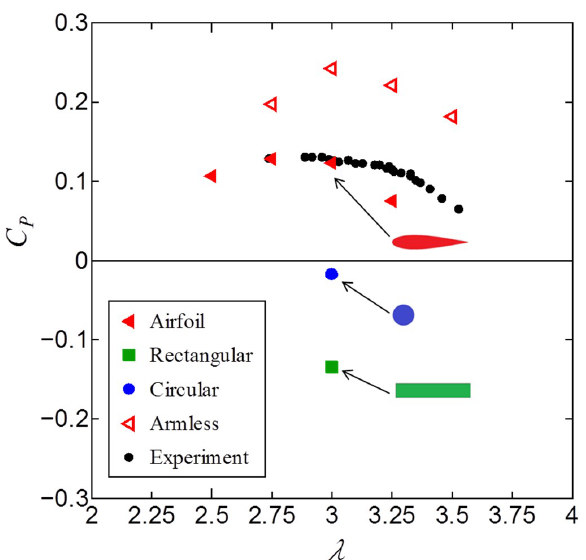
Figure 7. Comparison of power coefficients among the rotors with different cross-section arms. Black circles show the experimental data [26] of the two-blade experimental wind turbine (DU-H2-5075) in the case of no inclination of the rotational axis.